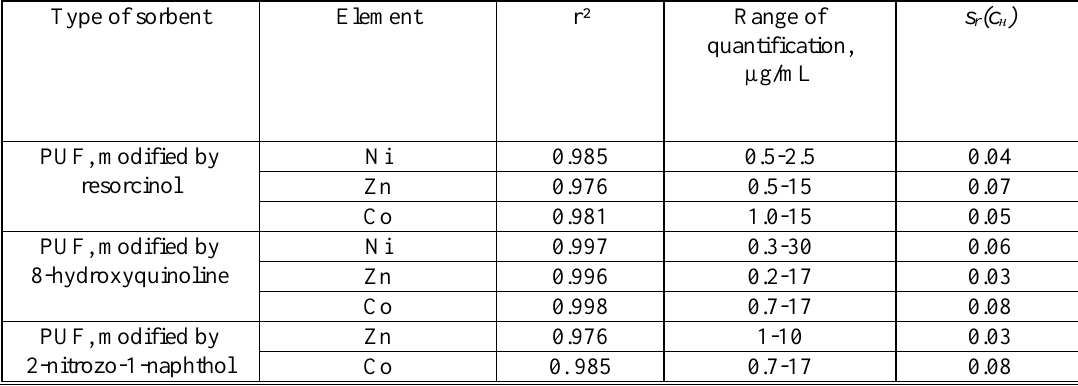
Table 1. Metrological characteristics of XRF determination of trace elements using chemically modified PUF